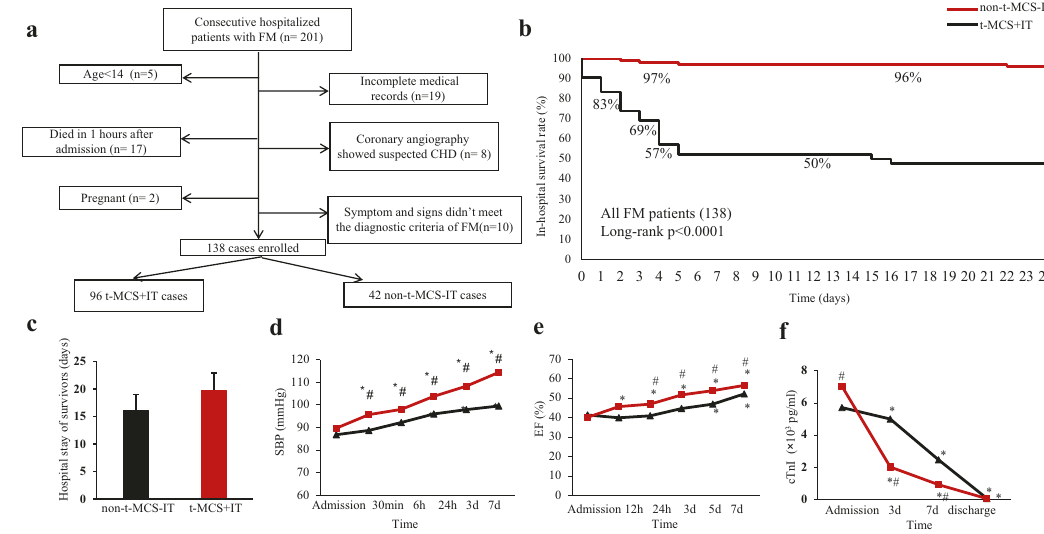
Fig. 1 a Flow diagram describing the selection of 138 subjects from the overall population diagnosed as FM. b The Kaplan – Meier curves of FM patients treated by different methods. c The hospital stays length of survived FM patients in both groups. d The changes of systolic blood pressure (SBP). * p < 0.05 vs baseline. # p < 0.05 vs non-t-MCS + IT group. e The changes of ejection fraction of left ventricle. f The changes of troponin I of FM patents. * p < 0.05 vs baseline. # p < 0.05 vs non-t-MCS + IT